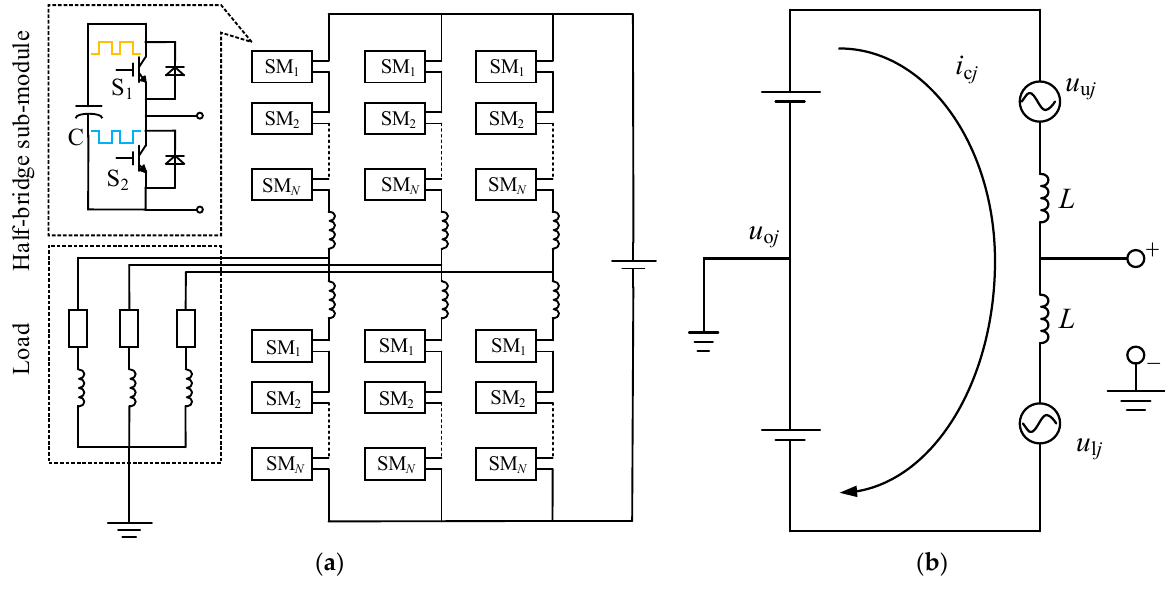
Figure 1. ( a ) Basic topology of MMC and ( b ) equivalent circuit of phase j .